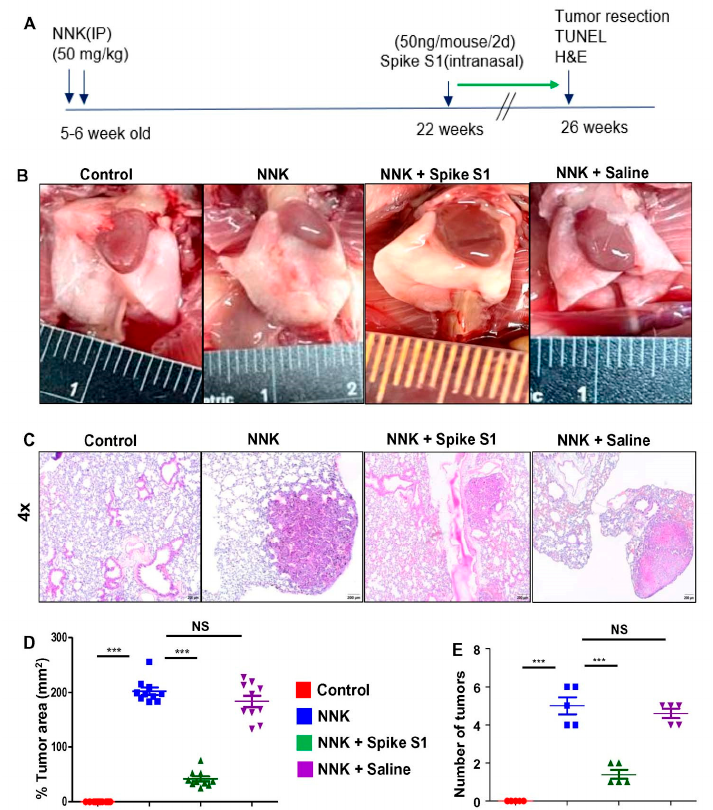
Figure 7. Intranasal administration of recombinant SARS-CoV-2 spike S1 causes regression of lung tumor in NNK-insulted female A/J mice. The experimental design is illustrated for NNK-induced lung cancer in A/J mice ( A ). Briefly, female A/J mice (5–6 week old) received two intraperitoneal (i.p.) injections of NNK (50 mg/kg body weight) one week apart. Tumor development was analyzed after 26 weeks of NNK intoxication. Mice were treated with spike S1 (50 ng/mouse/2 d) intranasally on alternate days starting from 22 weeks of NNK insult for 4 weeks followed by sacrificing mice on 26 weeks. Representative lung appearance in different groups of mice ( B ). Lung sections were stained for H&E ( C ). The histological tumor area was quantified in a 4x field as a percent of control ( D ). The number of lung lesions is shown in different groups of mice ( E ). Results are mean ± SD of 5 mice per group. *** p < 0.001; NS, not significant. Scale bar = 20 µm.